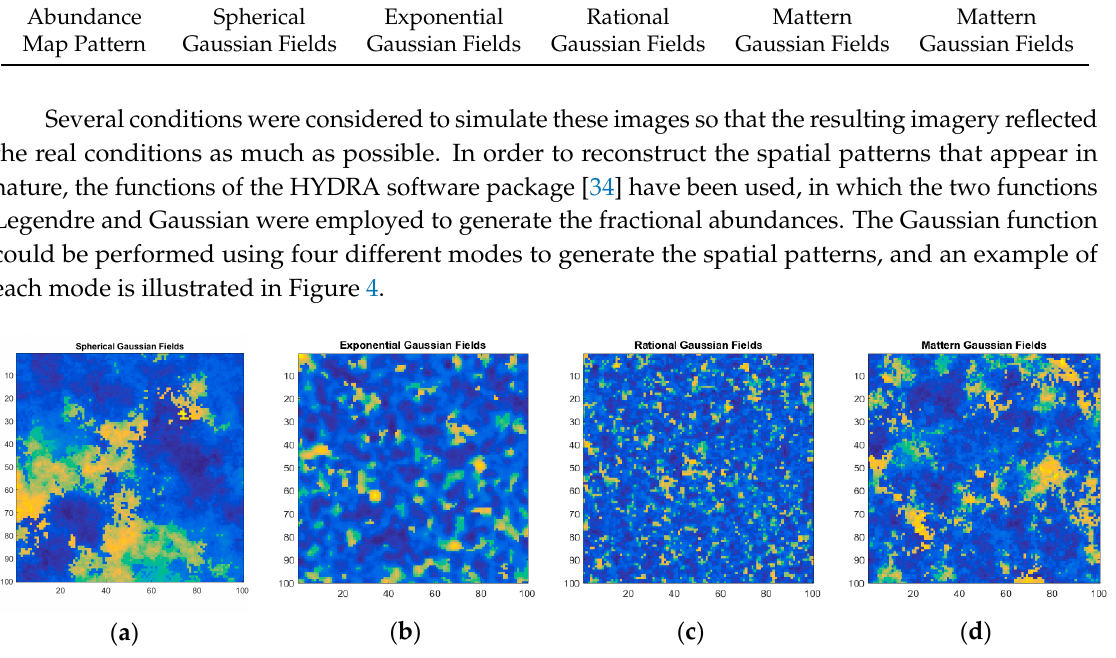
Table 1. The constituent spectra of the simulated images.